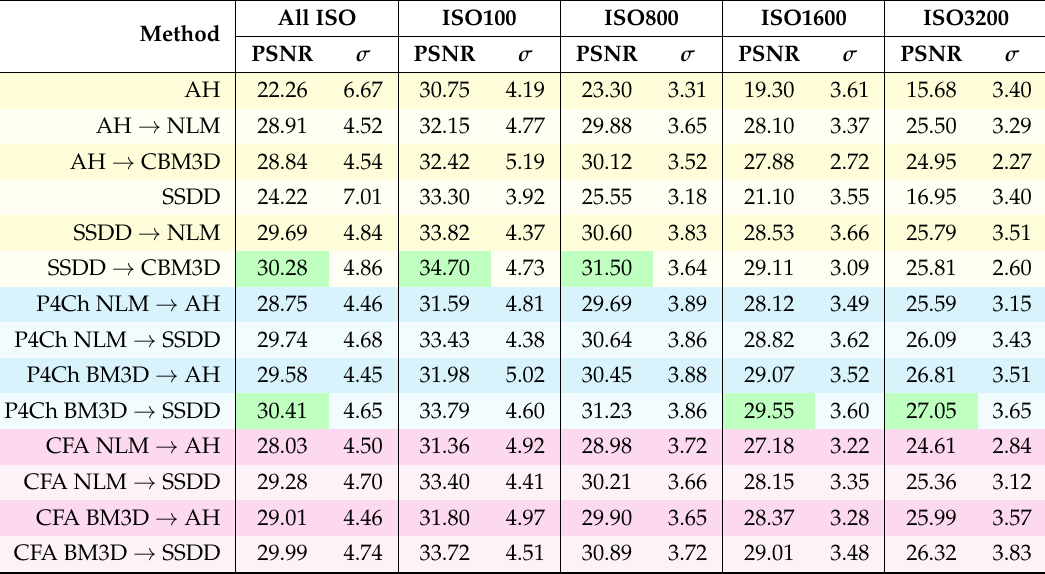
Table 2. Peak signal to noise ratio (PSNR) average results—all